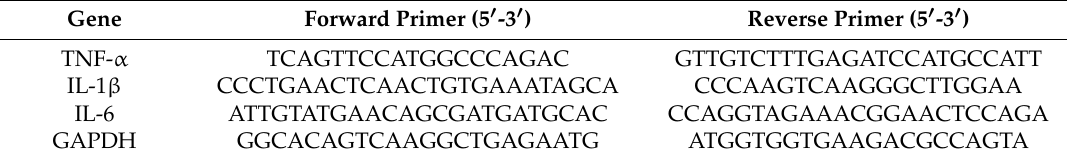
Table 1. The sequences of the primers used for real-time PCR assay. Gene